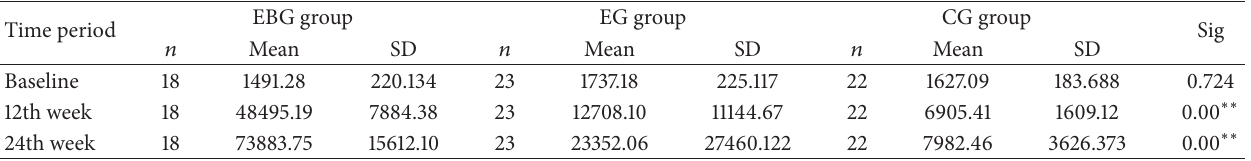
Table 3: Number of step counts for three groups across two point